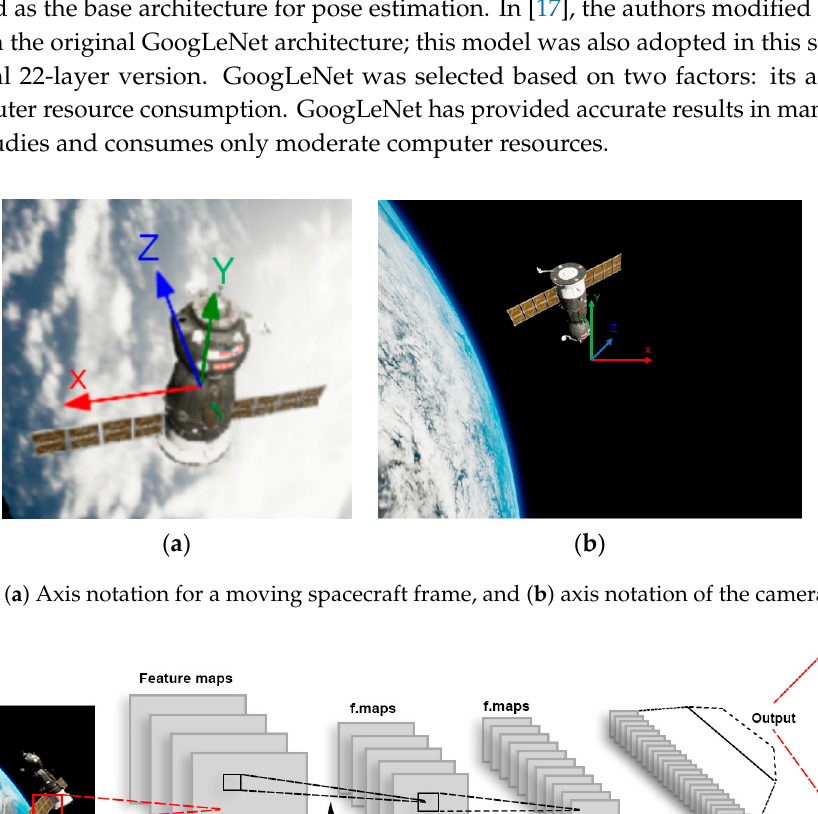
Figure 5. Resizing the image to fit the study format.